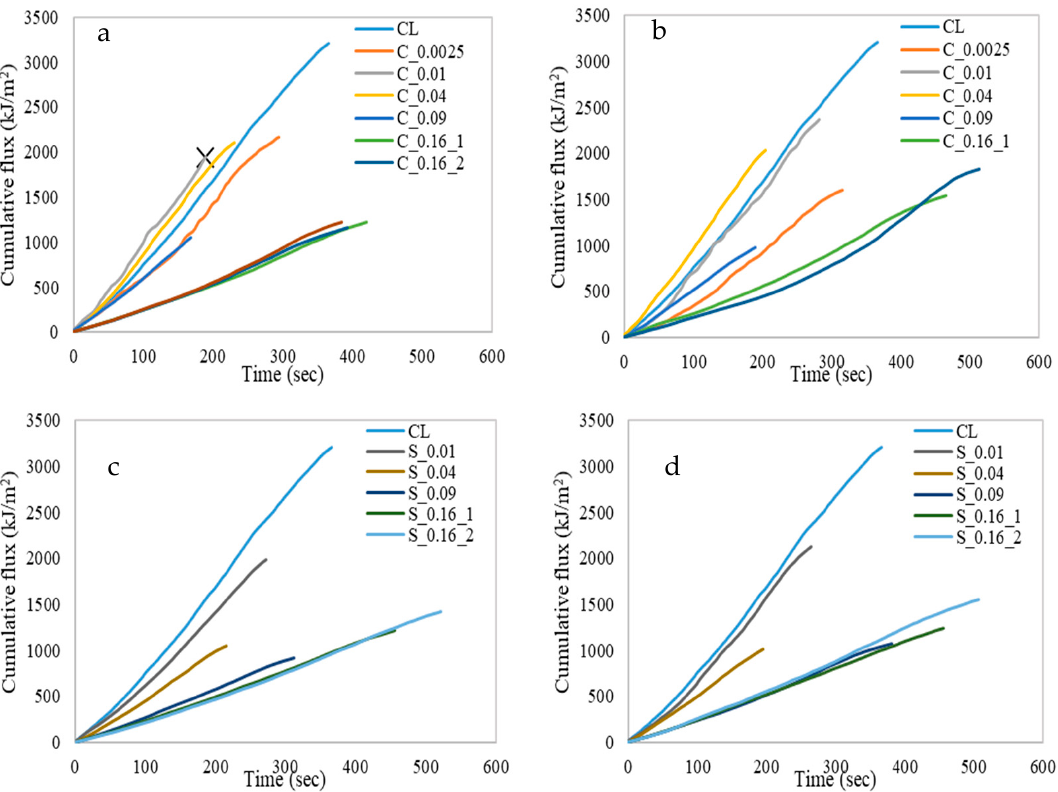
Figure 13. Cumulative heat flux curves in the post-flashover/steady-state phase, 30 cm from the door for ( a ) corner-open, ( b ) corner-poly, ( c ) slot-open, and ( d ) slot-poly horizontal opening cases.